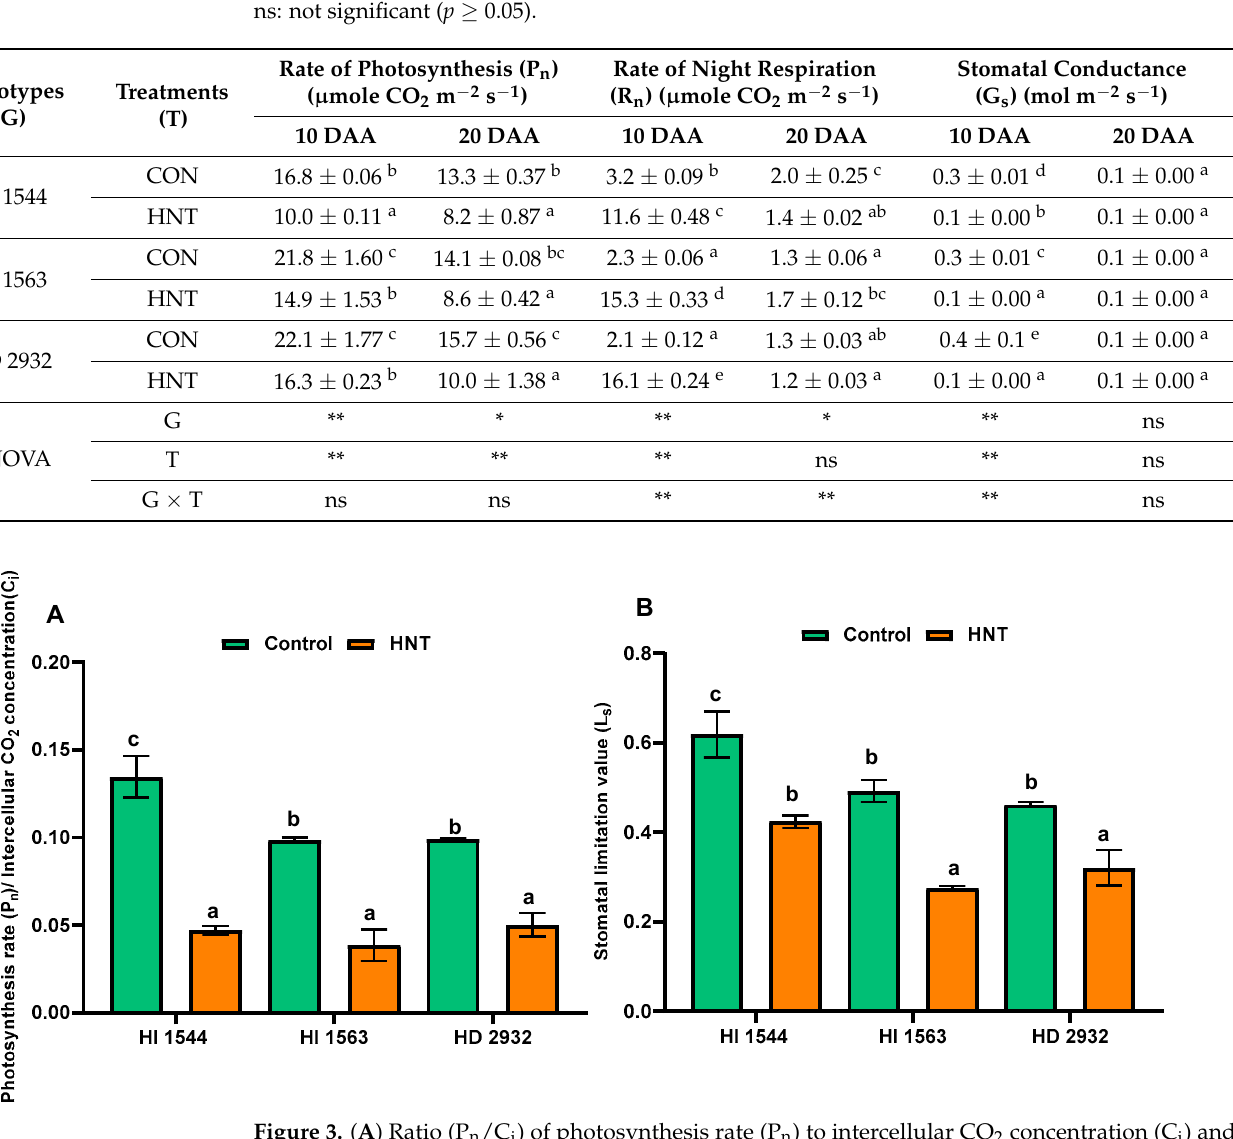
Figure 3. ( A ) Ratio (P n /C i ) of photosynthesis rate (P n ) to intercellular CO 2 concentration (C i ) and ( B ) stomatal limitation value (L s ) in the flag leaves of wheat genotypes grown under control and HNT conditions at 10 DAA. Values show mean ± SE. Data were obtained from three replications of each genotype. The separation of means was carried out using Duncan’s post hoc test ( p < 0.05). Means with different letters are significant.